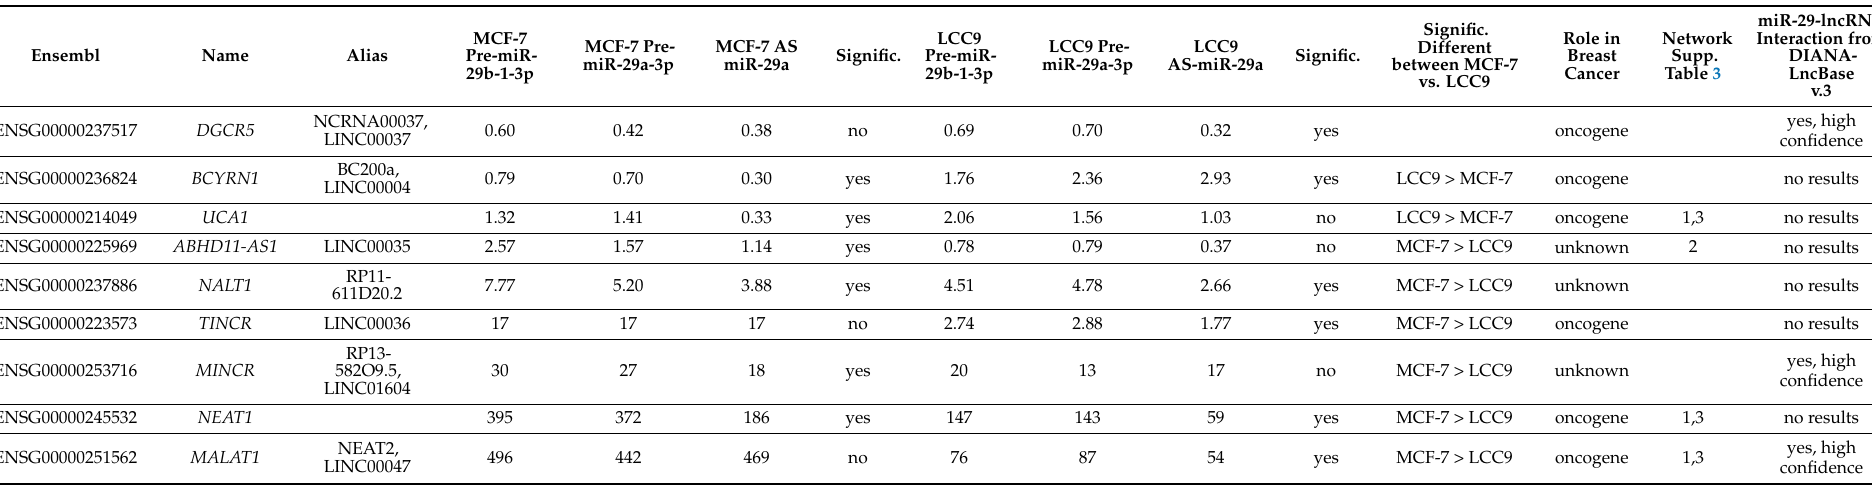
Table 2. lncRNAs upregulated by miR-29b-1-3p andmiR-29a-3p in MCF-7 and/or LCC9 breast cancer cells. MCF-7 or LCC9 cells were transfected with pre-miR-control, pre-miR-29b-1-3p, pre-miR-29a-3p, anti-miR-29a (which targets miR-29b-1/a), or anti-miR negative control for a 48 h prior to RNA isolation and RNA sequencing [35]. Values (FPKM) are the average of